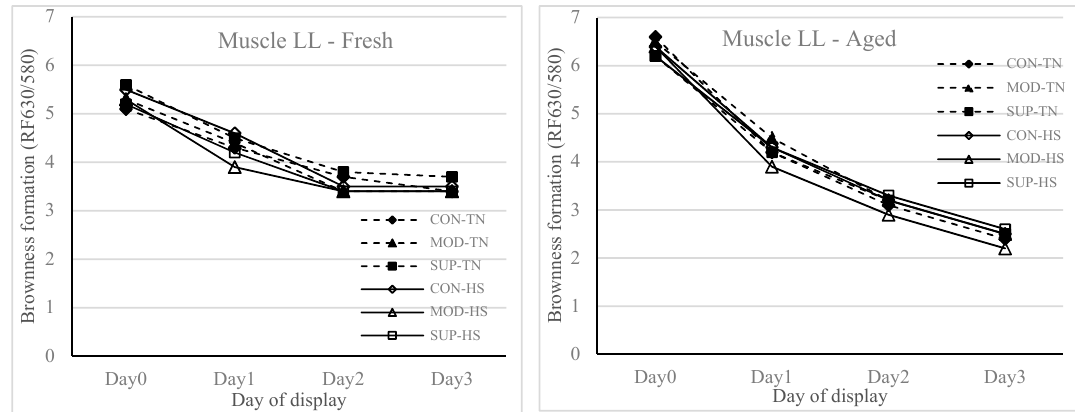
Figure 3. Brownness formation (reflectance 630/580) of fresh and aged (packed and stored for 42 days at 2 °C) meat (muscle LL) assessed at 1 h (Day 0), 24 h (Day 1), 48 h (Day 2) and 72 h (Day 3) of simulated retail display condition (3–4 °C) from lambs fed four weeks of experimental diets and followed by one week of thermal treatment. See Figure 1 for an explanation of the labels.